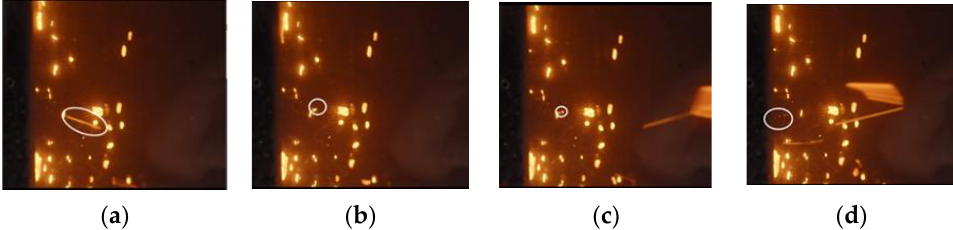
Figure 12. Firebrands continue to burn before penetrating the mesh, ( a ) approaching the firebrand, ( b ) stopping stationary at the hitting point, ( c ) continuation of burning and fragmentation into two